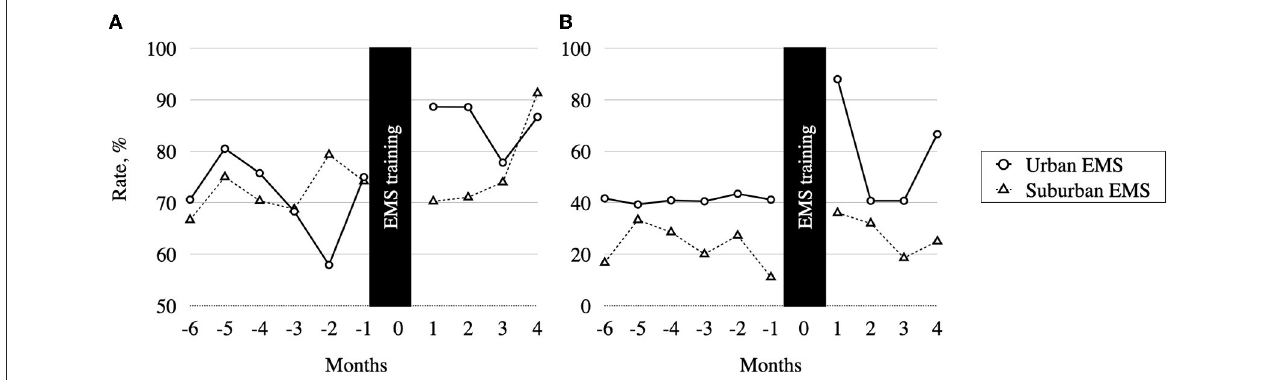
FIGURE 2 | Emergency medical services (EMS) performance before and after the EMS training. (A) Positive predictive value (PPV) for identification of stroke patients. (B) Onset-to-door time ≤ 90min rate stratified by EMS location.